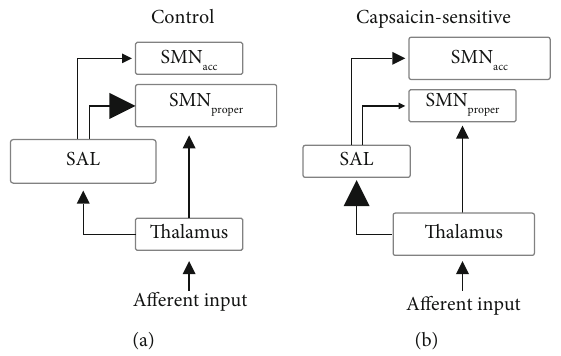
Figure 3: Visualization of the proposed changes in brain connectivity between the control (a) and capsaicin-sensitive subjects